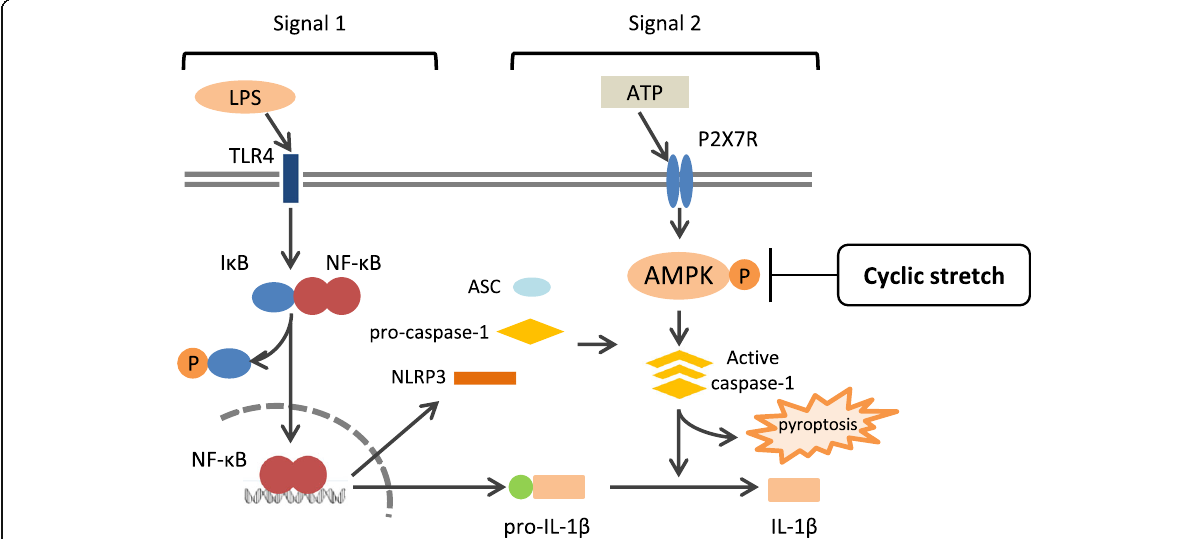
Fig. 2 NLRP3 inflammasome pathways and putative mechanism by which cyclic stretch negatively regulates IL-1 β secretion in murine macrophages. Treatment with LPS activates NF- κ B signaling via toll-like receptor (TLR) 4 (signal 1) and induces the expression of NLRP3 and pro-IL-1 β . Extracellular ATP activates inflammasomes via P2X7 receptors (signal 2) and induces the activation of caspase-1, which leads to the secretion of IL-1 β and pyroptosis. Cyclic stretch does not interfere with NF- κ B signaling (signal 1), but inhibits the activation of caspase-1 (signal 2) by attenuating the AMP kinase